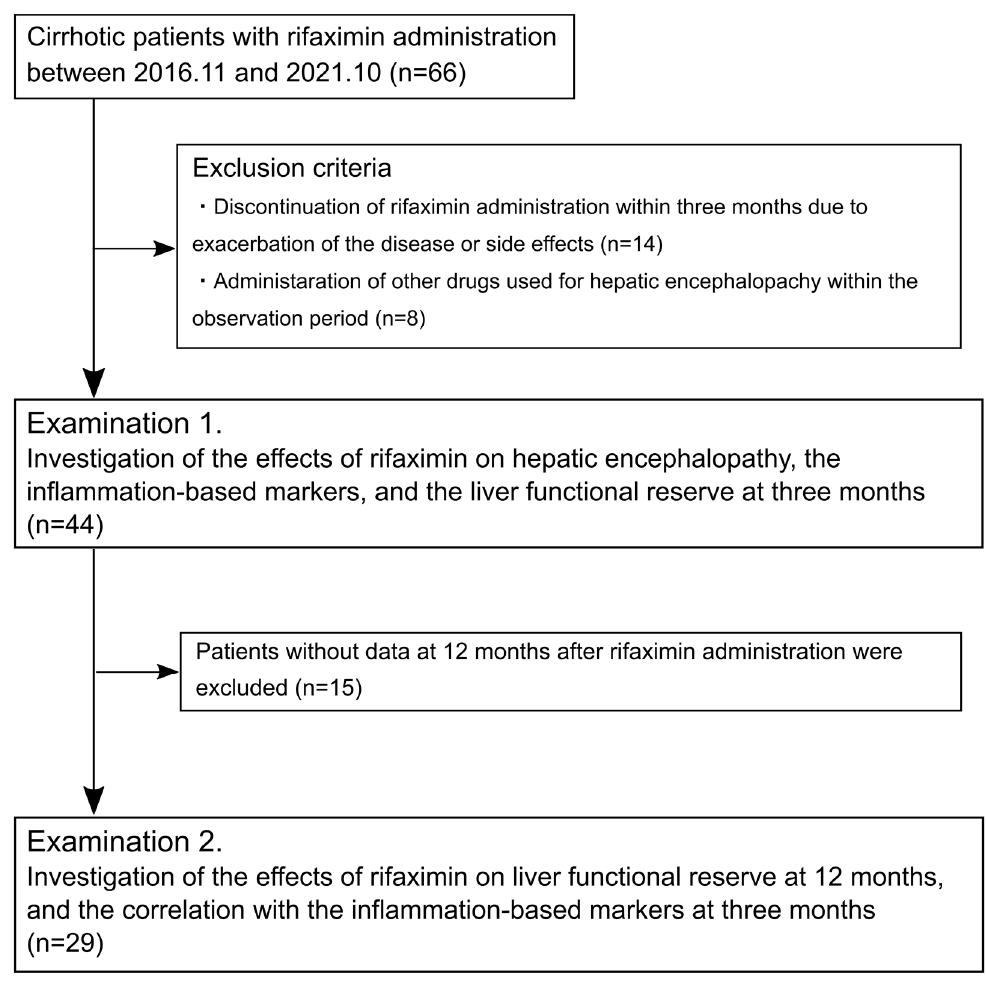
Figure 1. Flow diagram of the